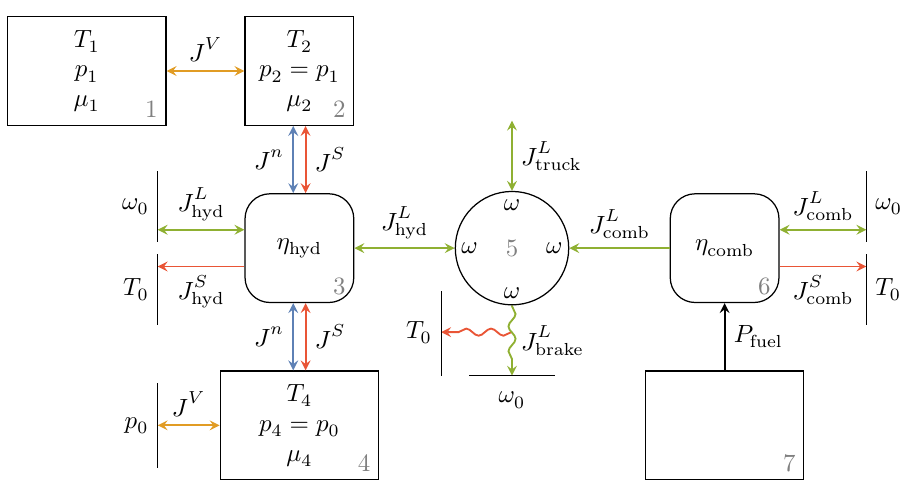
Figure 1. Endoreversible model used for fuel consumption minimization. The recuperation system is represented by the gas 1 and the hydraulic fluid 2 within the bladder accumulator, the hydraulic unit 3 and the hydraulic fluid tank 4. Engine 5 represents the cardan shaft and engine 6 is the combustion engine connected to a work reservoir 7 representing the diesel fuel tank. Energy transfers via the cardan shaft are carried by angular momentum fluxes. The angular momentum flux towards the chassis of the vehicle with angular velocity ω 0 = 0 represents energy dissipation at the conventional disc